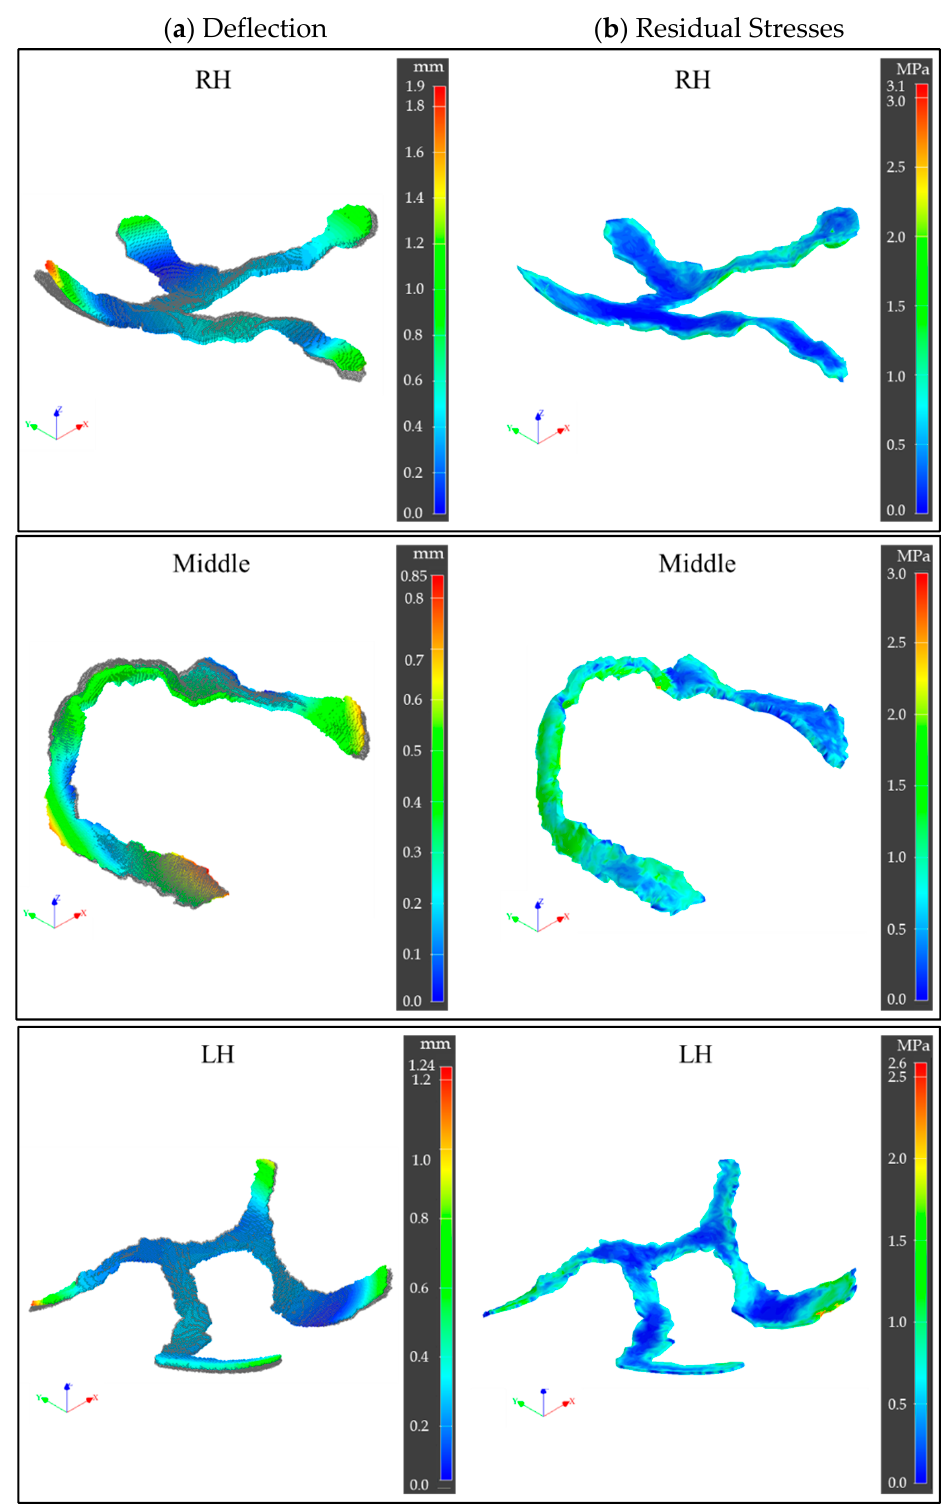
Figure 6. MF 3 printing process simulation results. ( a ) Part deflection overlapped on original CAD design; ( b ) residual stresses (von Mises) estimation, in RH, Middle, and LH parts. The implant edges were found to experience a higher rate of heat loss by convection and faster cooling due to larger surface areas, leading to earlier crystallization and solidification than the central regions. The resulting non-uniform volumetric shrinkage caused greater defection and residual stresses at these locations. Moreover, the lack of structural constraints at these free ends contributed to large deflections. Maximum deflection in the RH, Middle, and LH implant ends were observed to be 1.9 mm, 0.85 mm, and 1.24 mm, respectively, while in the central zone the deflections were as low as zero. The difference among the parts can be attributed to geometry aspect ratio